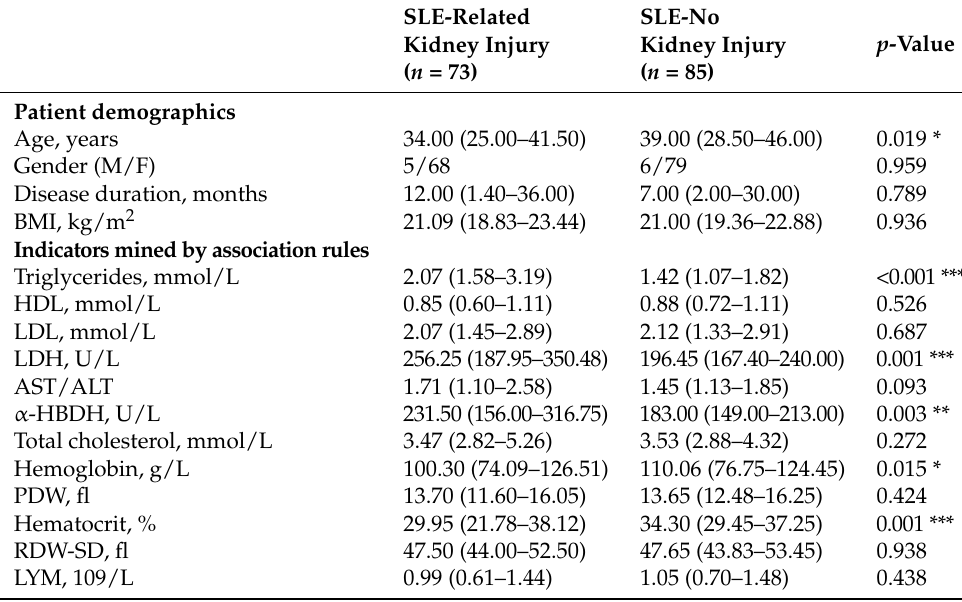
Table 3. Univariate analysis of demographics and clinical characteristics associated with SLE-related kidney injury patients.